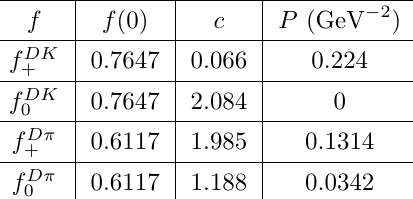
(cid:25) and D K transitions ! !